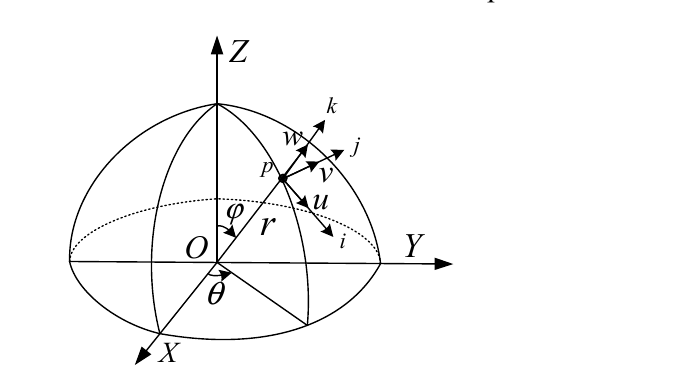
Figure 1. The illustration of the mean shell of the hemispherical